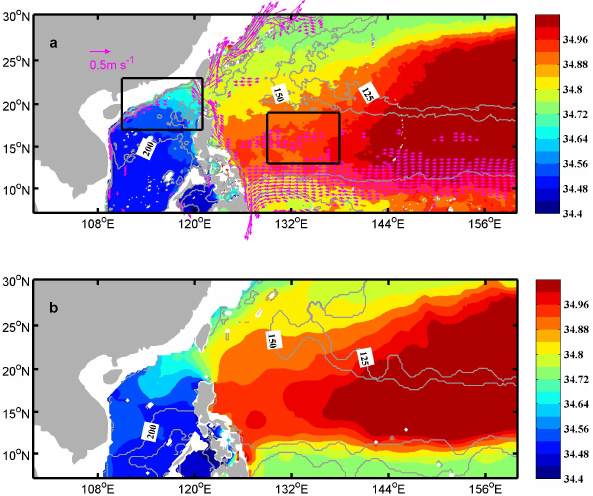
Figure 1. Distribution of the maximum salinity (color shading; PSU) and its depth (grey contours; m): (a) HYCOM; (b) WOA01. The boxes show the regions used for T-S analysis in Fig. 2. Sub- surface currents (vectors, pink) larger than 0.1ms − 1 are superim-